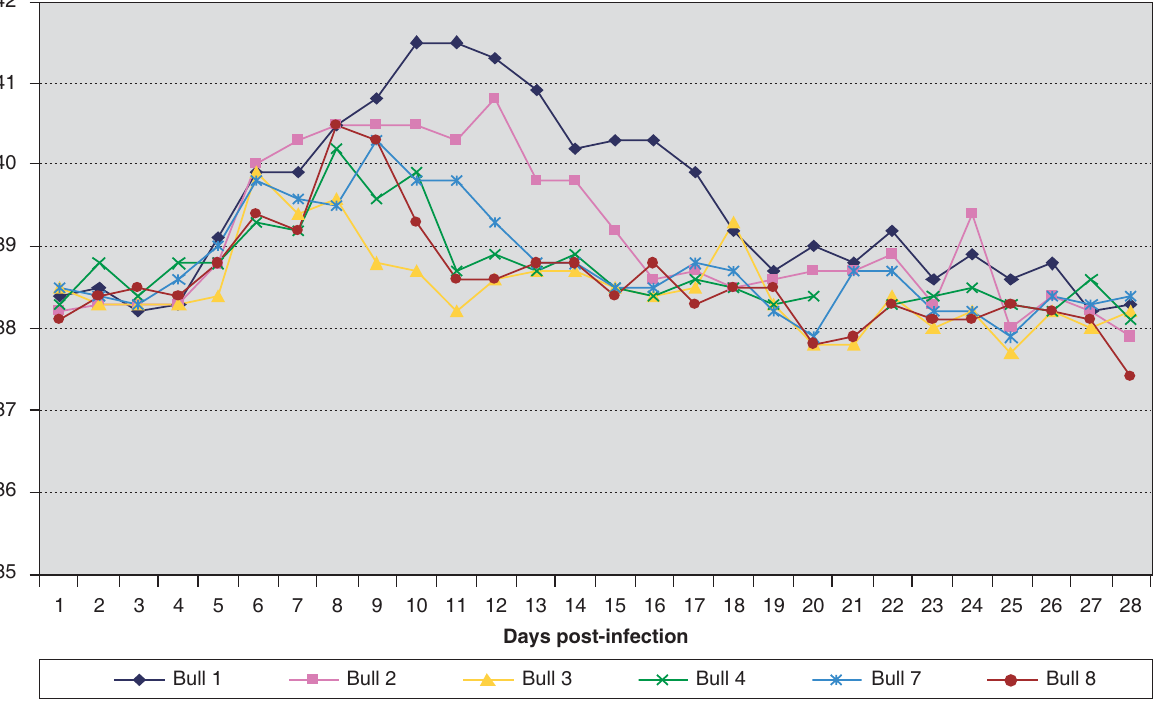
FIG. 1 Temperature reaction in the